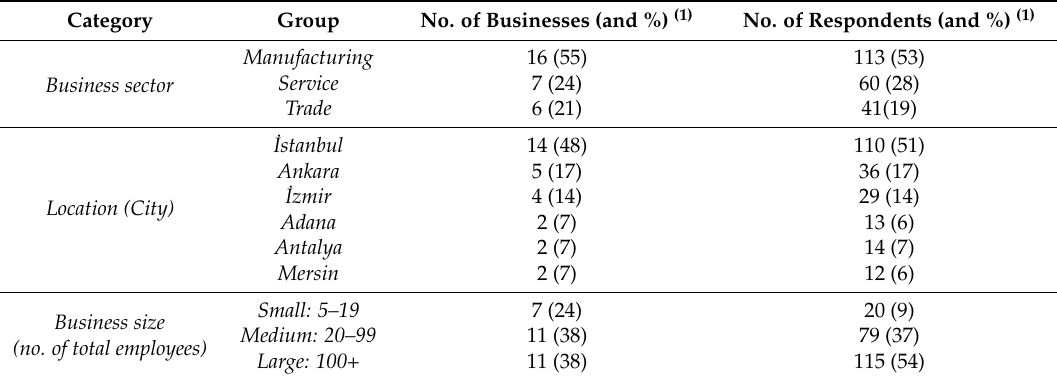
Table 4. Characteristics of 29 businesses ( N:214 ).